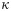
Application of the mean-field theory to the multi-area model.A Trajectories of Eq (1) starting inside the separatrix converge to an unstable fixed point. Trajectories starting close to the separatrix are initially attracted by the unstable fixed point but then repelled in the fixed point’s unstable direction and finally converge to a stable fixed point. B Firing rate averaged across populations over time. Integration of Eq (1) leads to convergence to either the low-activity (LA) or the high-activity (HA) attractor for different choices of the external input factor κ, with κ=1 the original level of external drive. We show eight curves with κ varying from 1.0 to 1.014 in steps of 0.002 and two additional curves for κ=1.007662217,1.007662218. The curves for the largest factor (κ=1.007662217) that still leads to the LA state and for the smallest factor (κ=1.007662218) that leads to the HA state are marked in blue and red, respectively. The four curves with κ≤1.006 coincide with the blue curve. C Euclidean norm of the velocity vector in the integration of Eq (1) for the different choices of κ. The vertical dashed line indicates the time sc of the last local minimum in the blue curve. D Stationary firing rate in the different areas and layers of the model in a low-activity state for κ=1.0 as predicted by the mean-field theory (same display as in Fig 3). E As D, but showing the high-activity state for κ=1.125.